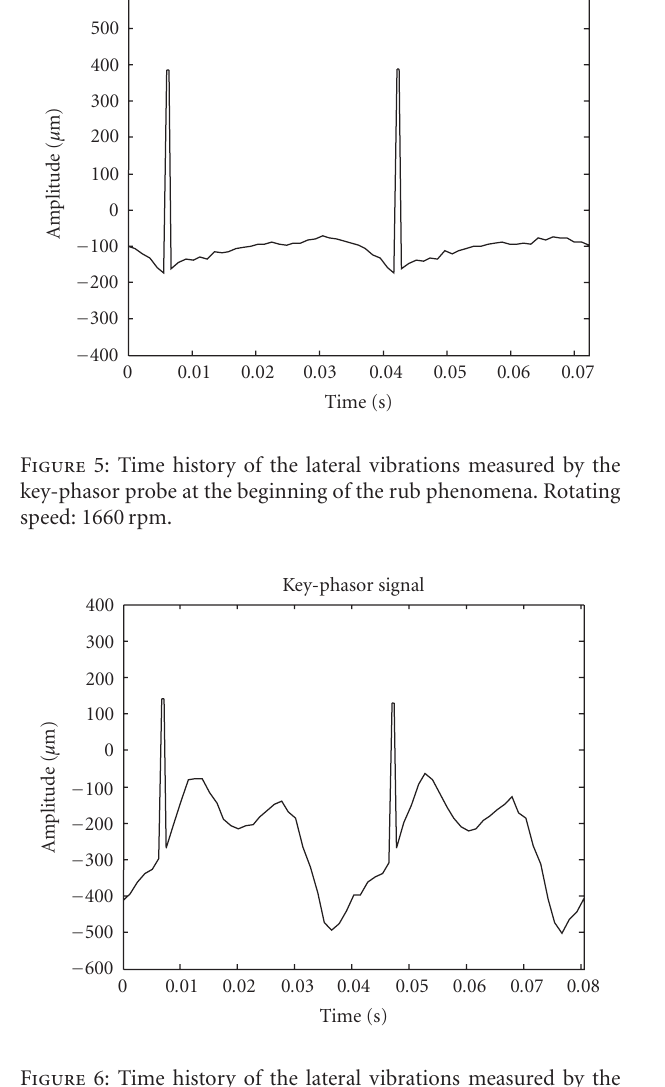
Figure 6: Time history of the lateral vibrations measured by the key-phasor probe during the coastdown carried out after the rub occurrence. Rotating speed: 1490 rpm.